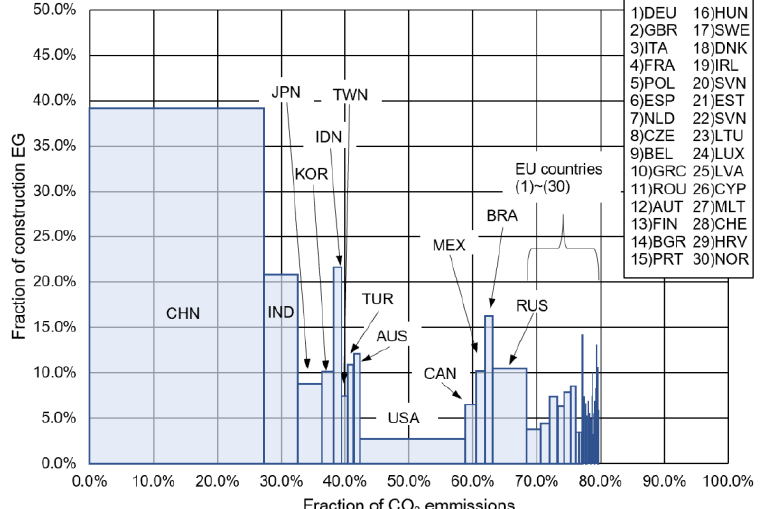
Figure 4. Fraction of construction EG and total CO 2 emissions.